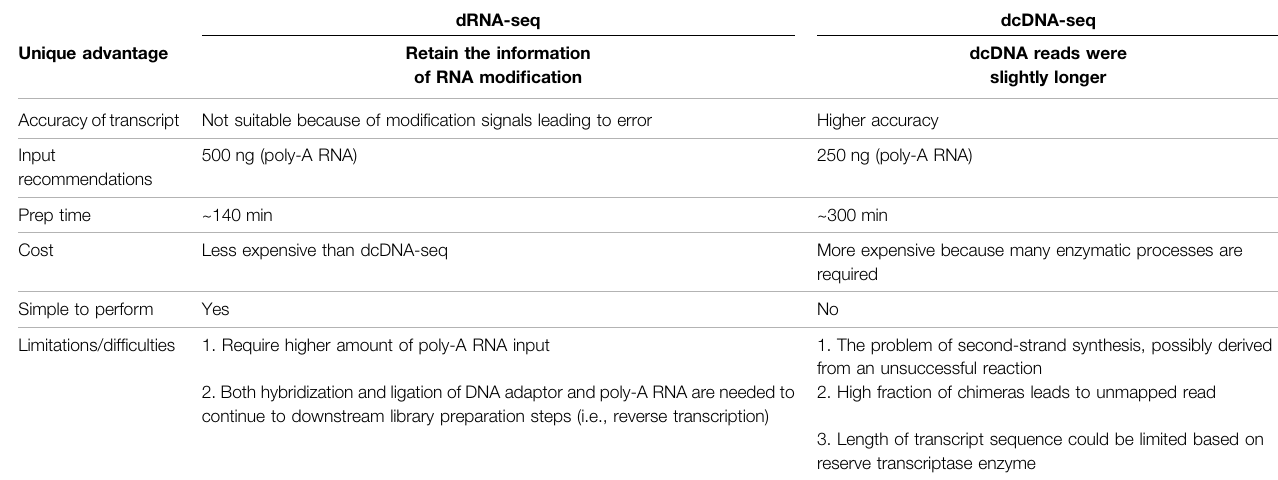
TABLE 1 | Comparison of dRNA-seq and